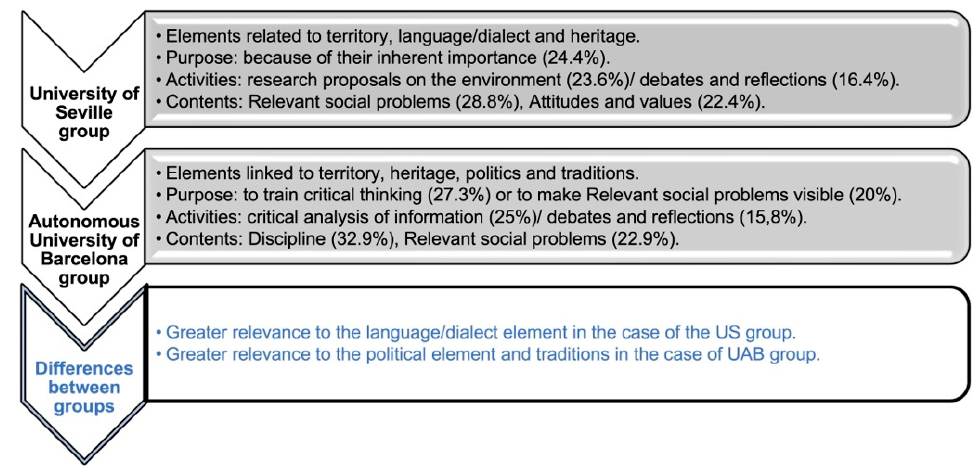
Figure 6. Representations on practical perspectives and their differences.